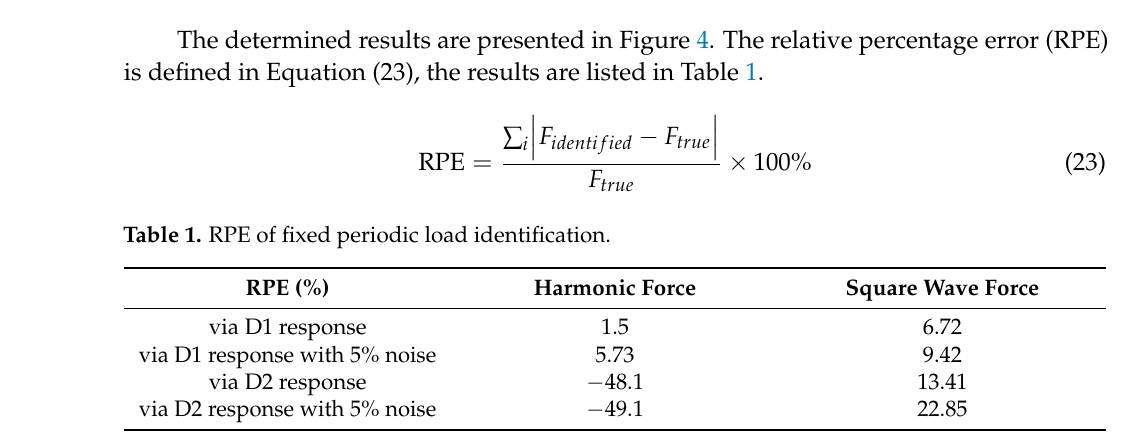
Figure 3. L-curves of TLSF response matrix and Impulse response matrix with respect to D1 with 5% noise. ( a ) L-curve of 𝜦 ; ( b ) L-curve of I .